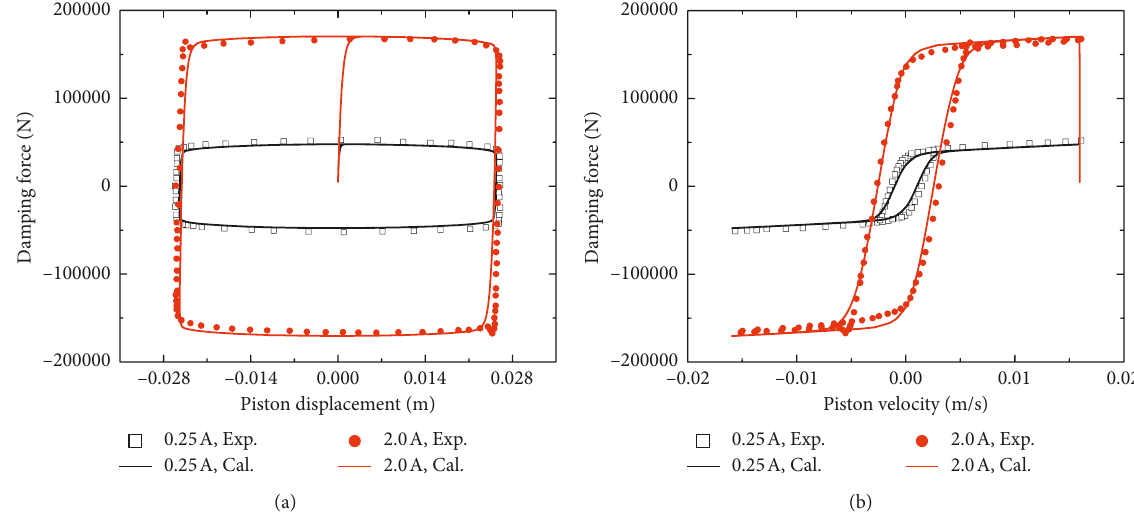
Figure 12: Model predictions (lines) and experimental data (Yang [34]) of hysteretic behavior of MR dampers under sinusoidal dis- placement excitations of 2.54cm, 0.1Hz. (a) Displacement-force hysteresis. (b) Velocity-force